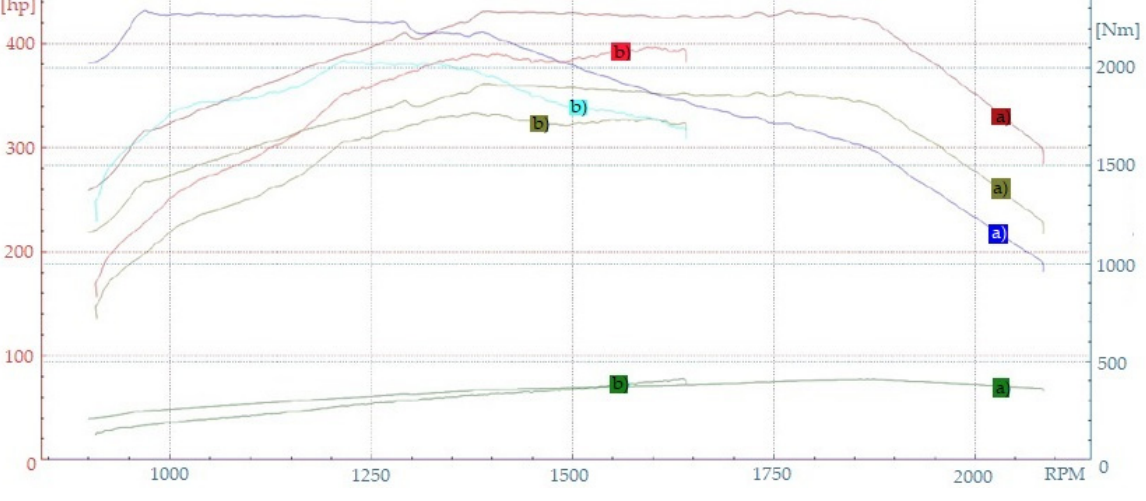
Figure 16. A graph showing the results of external characteristics for the research where: ( a ) at- tempts were made to reduce the impact of errors, and ( b ) the errors mentioned in this work are combined (authors’ source). The above chart shows the wrongly selected measurement course and the influence of other factors mentioned in this paper, which resulted in the torque and power values lower by 8.2% and 11.2%. The scale of problems resulting in inaccurate tuning of the dual-fuel system is pre- sented in the map of diesel fuel replacement with gaseous fuel. The higher its value in a given field and the higher the total value of the exchange (while maintaining torque and power waveforms similar to single-fuel operation), the better. Figure 17 below shows the comparison of the results of tuning the map of conversion of diesel fuel to gas fuel. In the example below you can clearly see much worse fuel exchange values, and the overall ex- change value decreased by 9.2%.